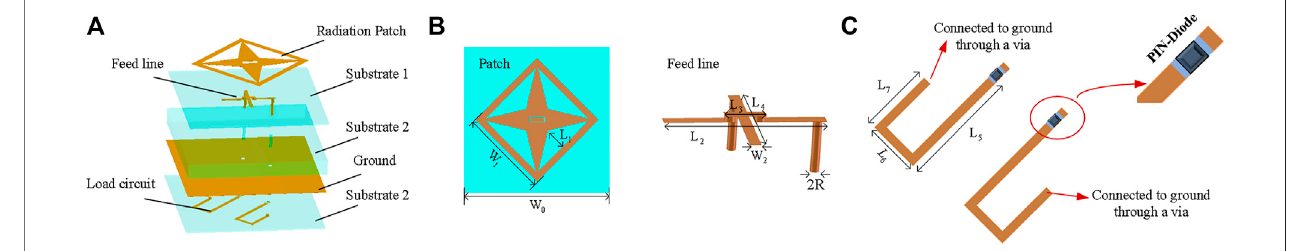
FIGURE 1| Schematic representation ofthe proposed meta-atom. (A) Explosive view; (B) sketch ofthe patch and feed line; (C) load circuitcomposed of the PIN- diode and transmission line in